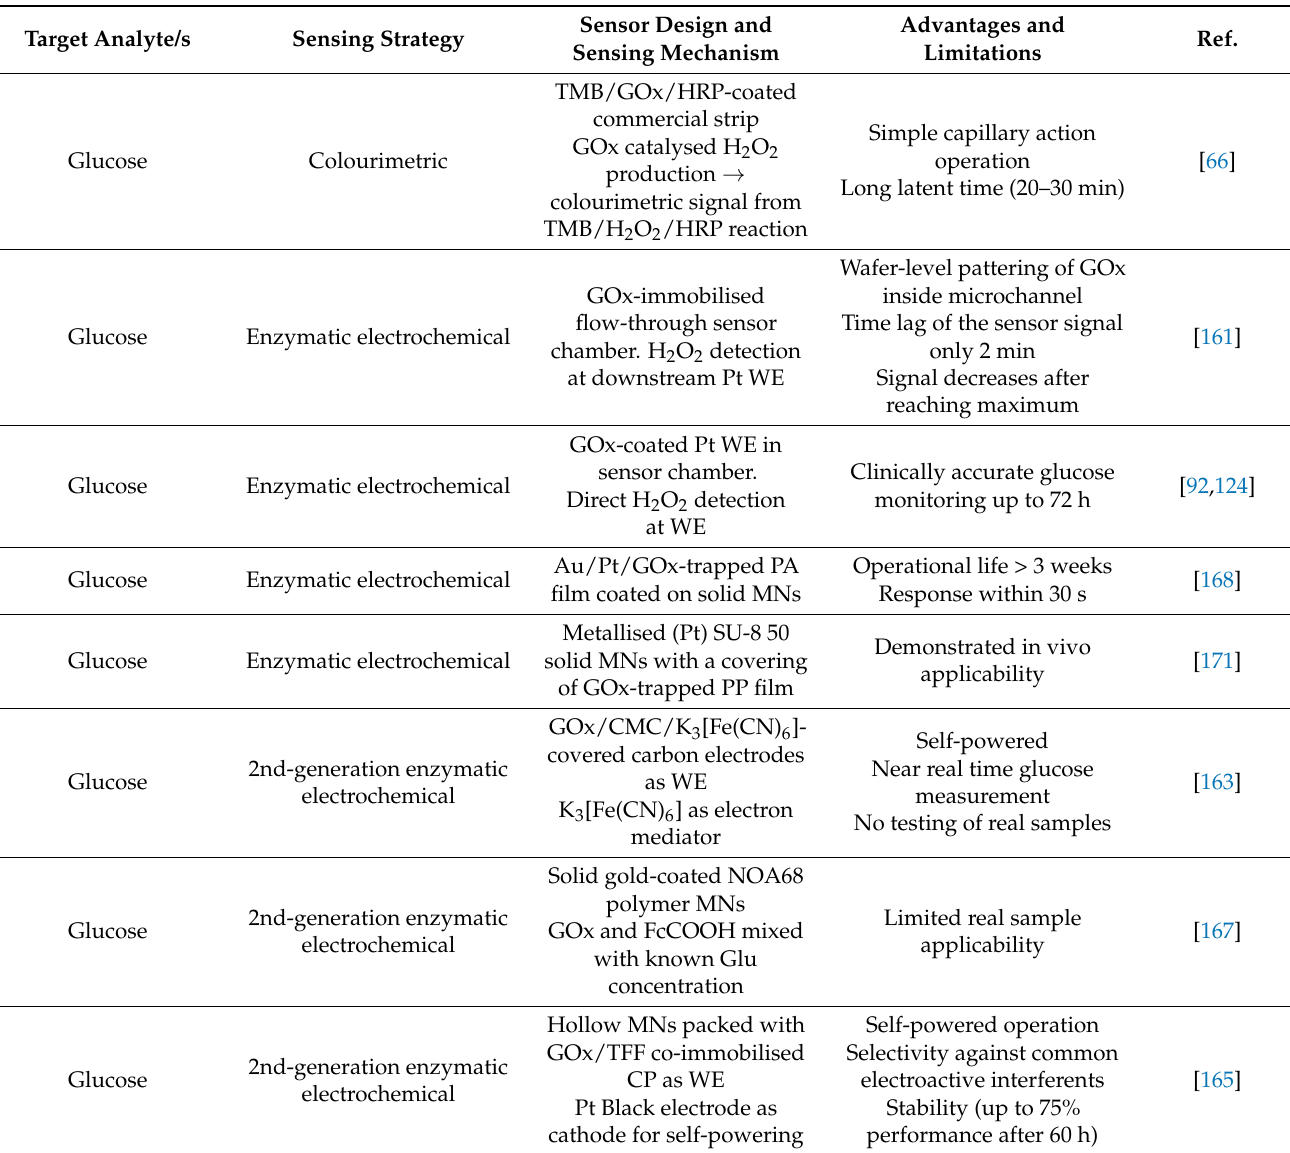
Table 1. Summary of MN-based biomolecule sensing